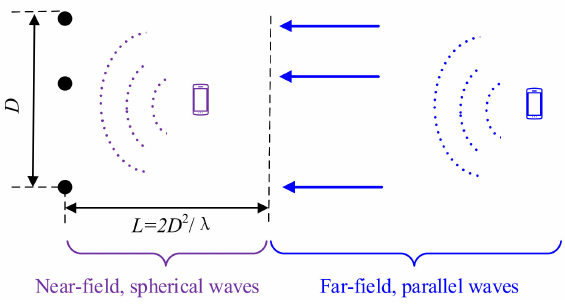
Figure 3. Illustration of near-field source and far-field